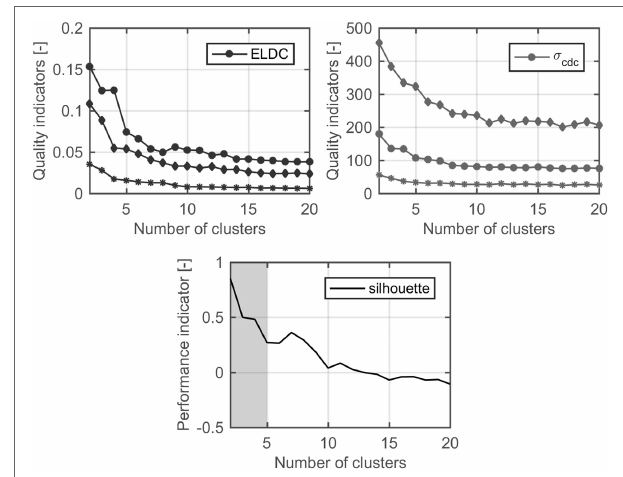
FIGURE 2 | Spatial data reduction quality indicators for heating degree days (diamond), global horizontal irradiance (star), cooling degree days (circle), and performance